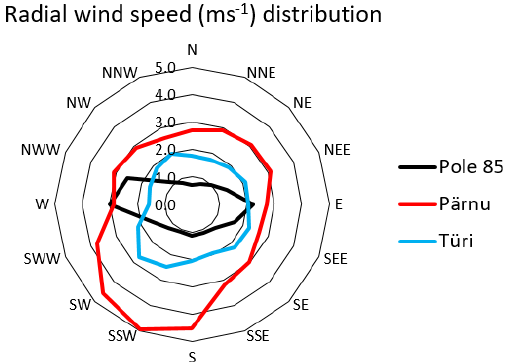
Figure 4. Directional wind speed distribution in pole 85 compared to hourly weather observation data from Pärnu and Türi weather